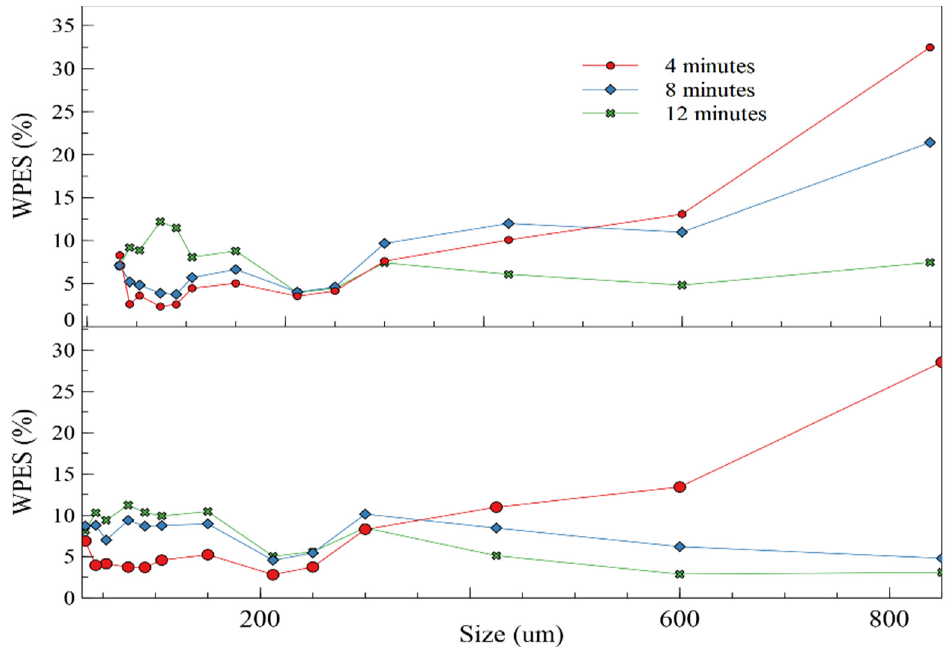
Figure A3. WPES for the same mineral: Top , with the second operating protocol (145 iron balls distributed in different sizes between 1½”, 1”, and 7/8”, with a total load of 9.341 kg; roller at 70 rpm; and 50% solid). Bottom , with the third operating protocol (238 iron balls distributed in different sizes between 1”, 7/8”, ¾”, and ½”, with a total load of 6.658 kg; roller at 70 rpm; and 67% solid).